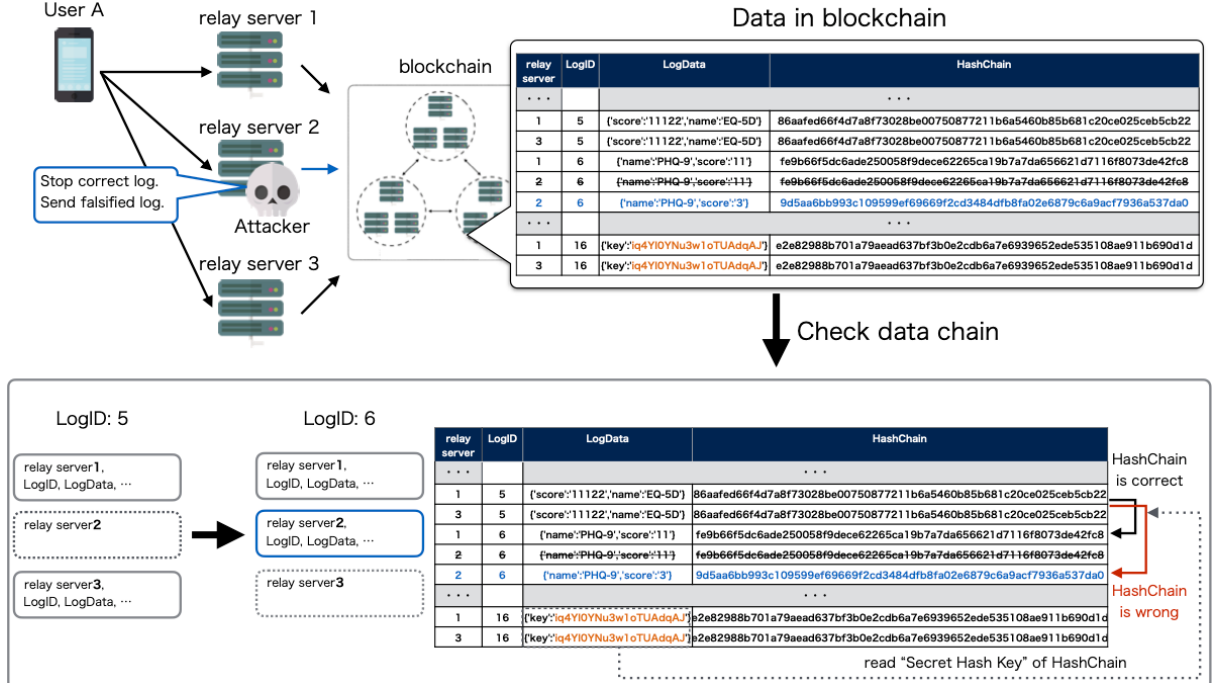
Figure 8. Simulation of data falsification by fraudulent access to the relay server. If an attacker successfully accesses the relay server fraudulently, the attacker can send falsified data to the blockchain. The falsified data from the hacked server will be detected by the integrity of the